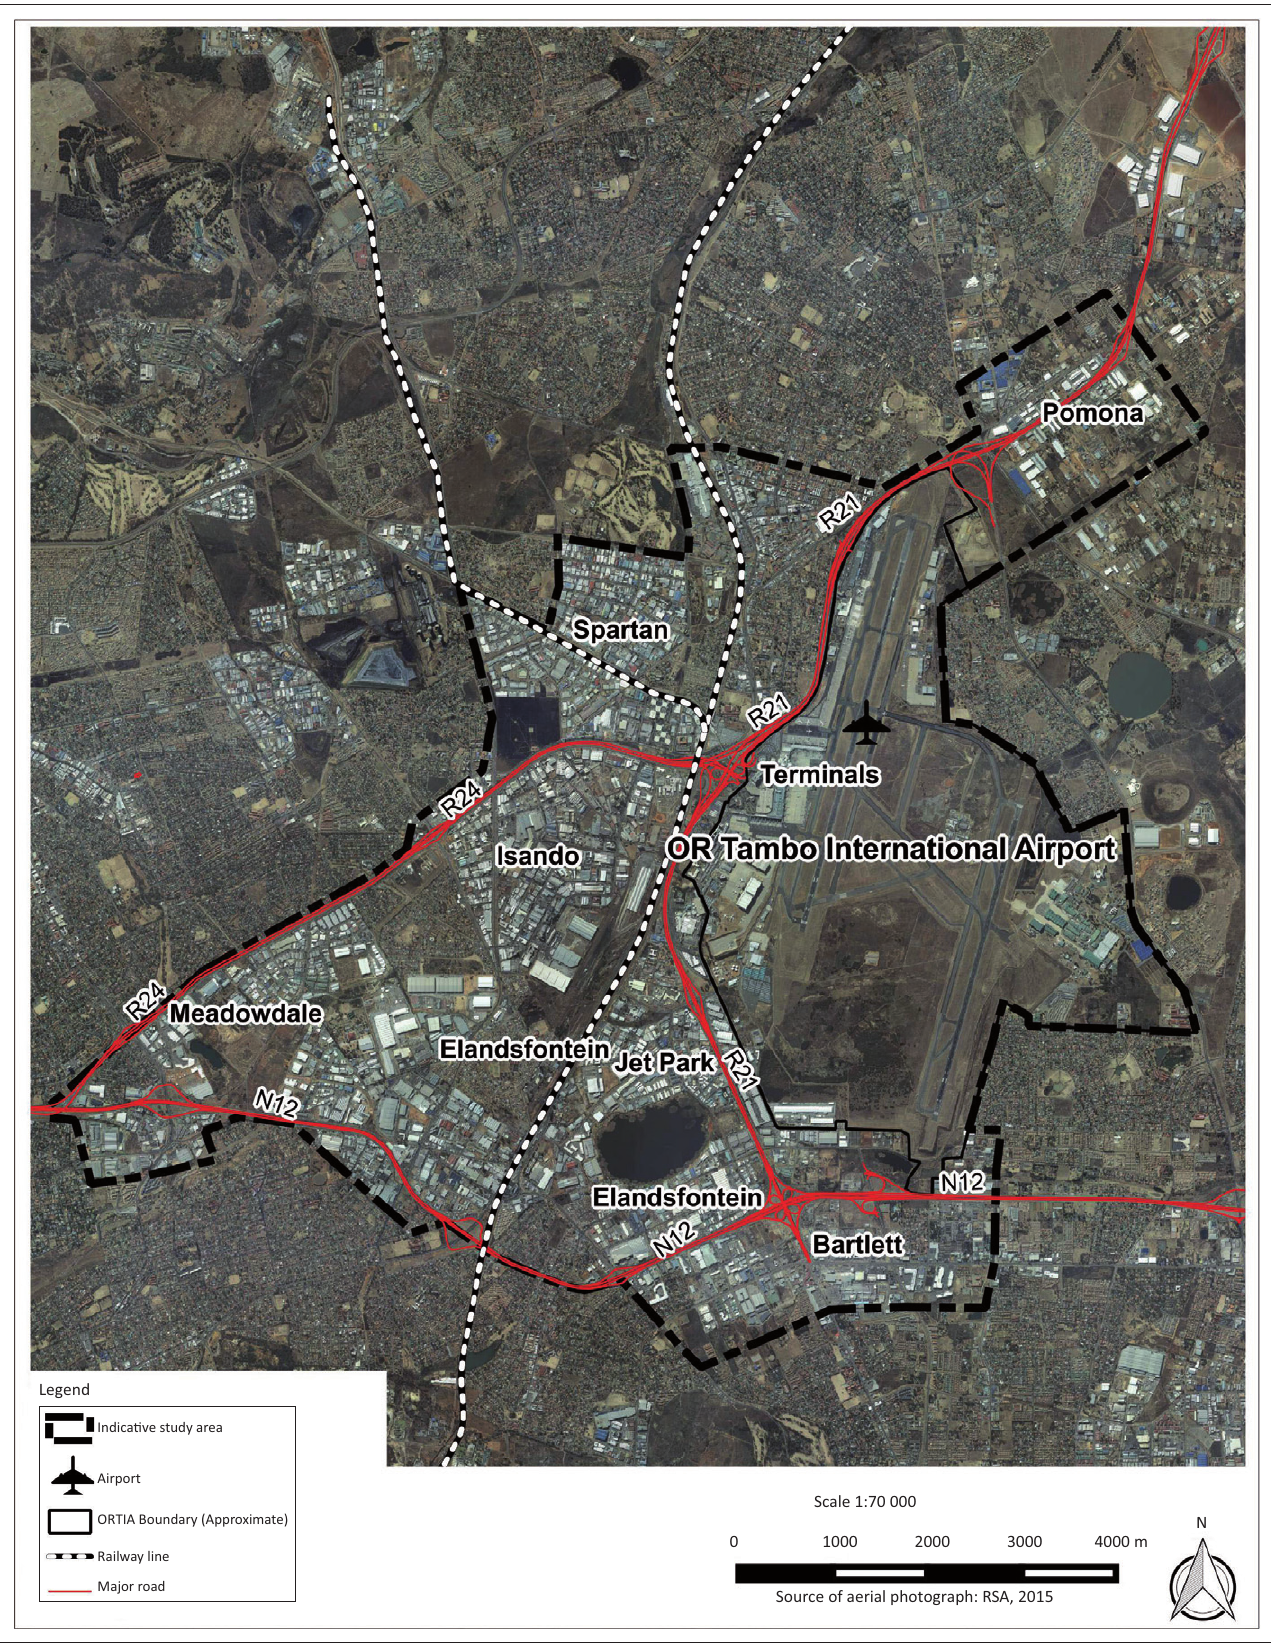
FIGURE 1: O.R. Tambo airport-centric